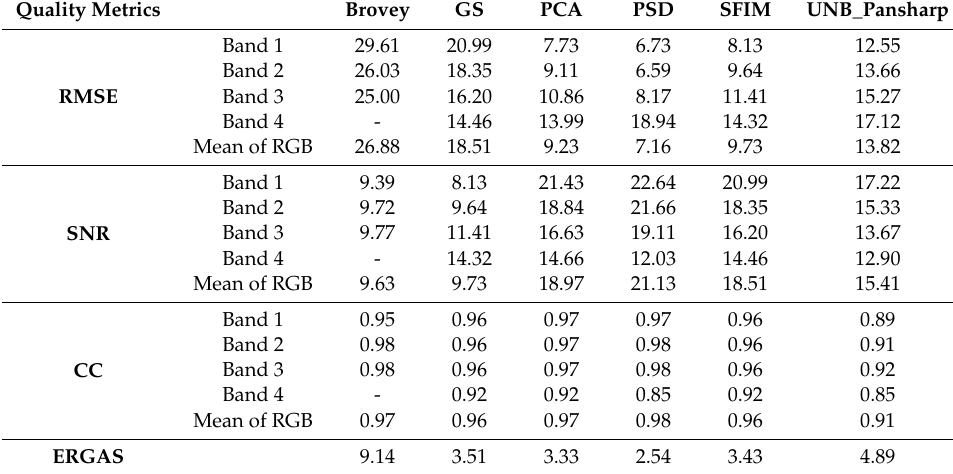
( h ) SFIM ( i ) UNB_Pansharp Figure 5. Fusion results produced by different algorithms, where ( a ) is the panchromatic image, ( b ) is the low-resolution multi-spectral image, ( c ) is the high-resolution multi-spectral image, ( d ) is the fused image produced by PSD, ( e ) is the fused image produced by principal component analysis (PCA), ( f ) is the fused image produced by Brovey, ( g ) is the fused image produced by Gram-Schmidt (GS), ( h ) is the fused image produced by smoothing filter-based intensity modulation (SFIM), and ( i ) is the fused image produced by UNB_Pansharp. Table 4. The evaluation parameters of different fusion results. SNR—signal-to-noise ratio; CC—correlation coefficient; ERGAS—relative dimensionless global error in synthesis; GS—Gram–Schmidt; PCA—principal component analysis; PSD—panchromatic spectral decomposition; SFIM—smoothing filter-based intensity modulation.